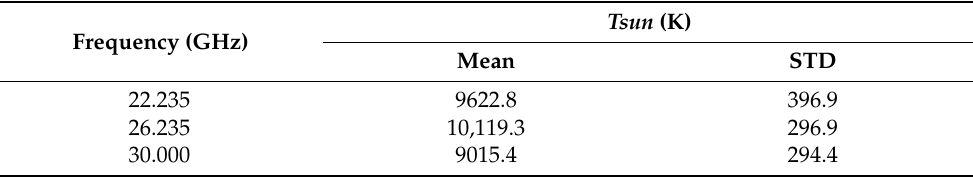
Figure 8. The variation in the solar TB on 18 June 2020 at 22.235, 26.235, and 30.0 GHz. Tsun is the solar TB. Table 3. The statistical results of the solar TB ( Tsun ) on 18 June 2020 at the three frequencies. The “Mean” and “STD” are the mean value and standard deviation,